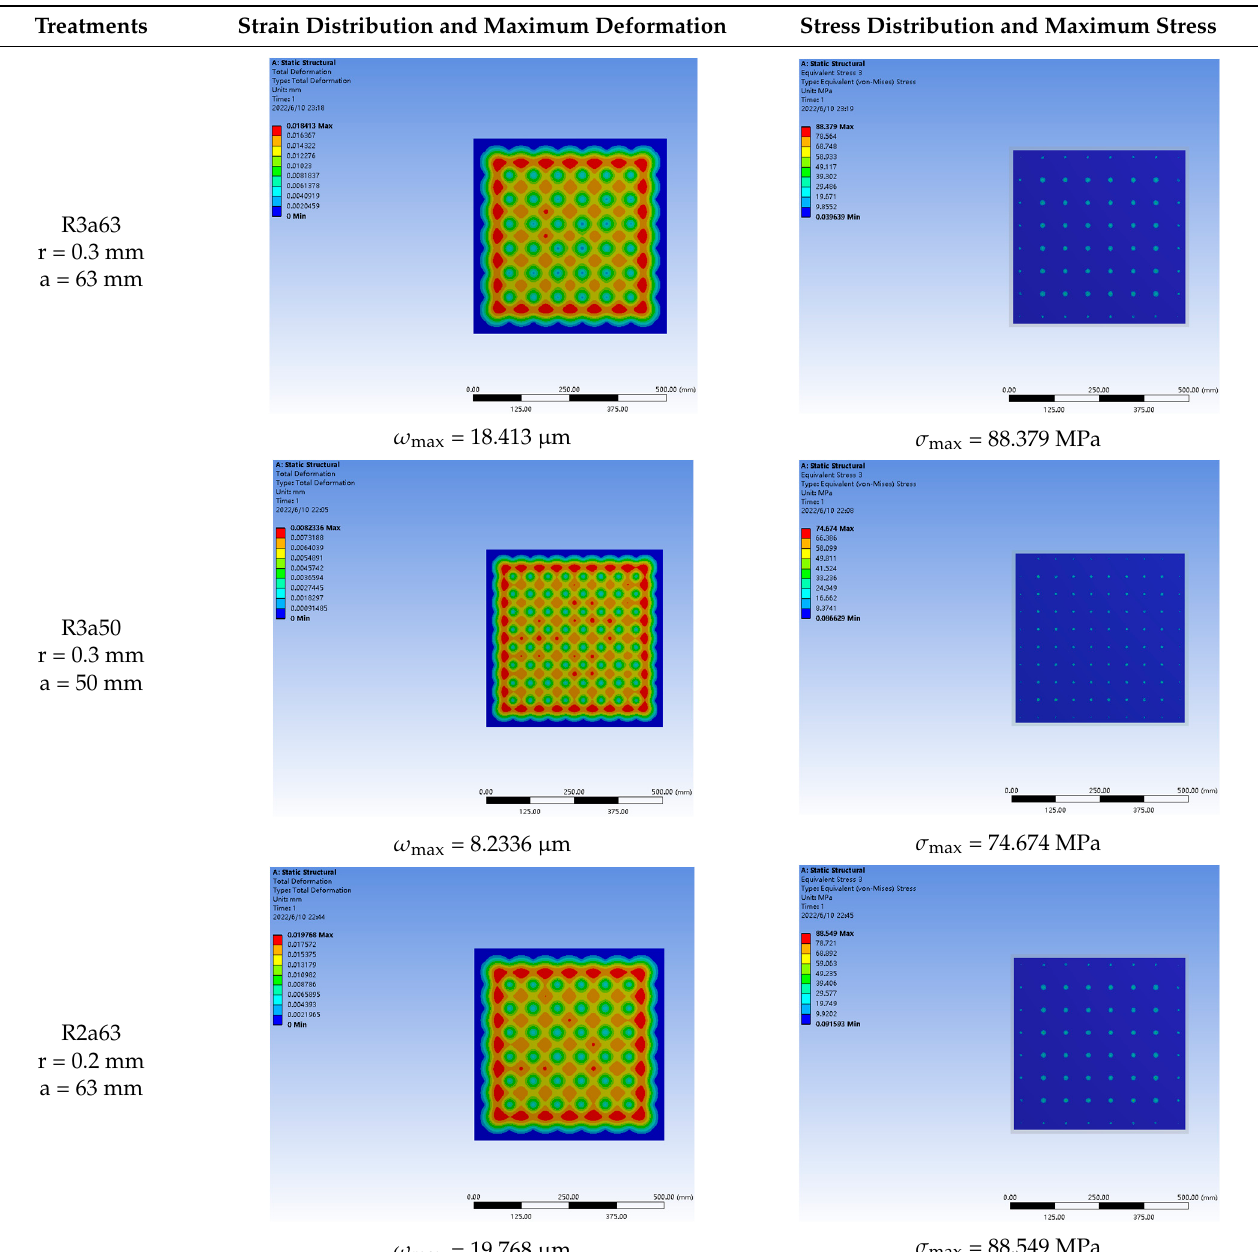
Table 4. The supporting stress and deformation of the glass substrate under different supporting pillar radii and spacing distances. R3a63, with a 0.3 mm supporting pillar radius and 63 mm spacing distance; R3a50, with a 0.3 mm supporting pillar radius and 50 mm spacing distance; R2a63, with a 0.2 mm supporting pillar radius and 63 mm spacing distance.